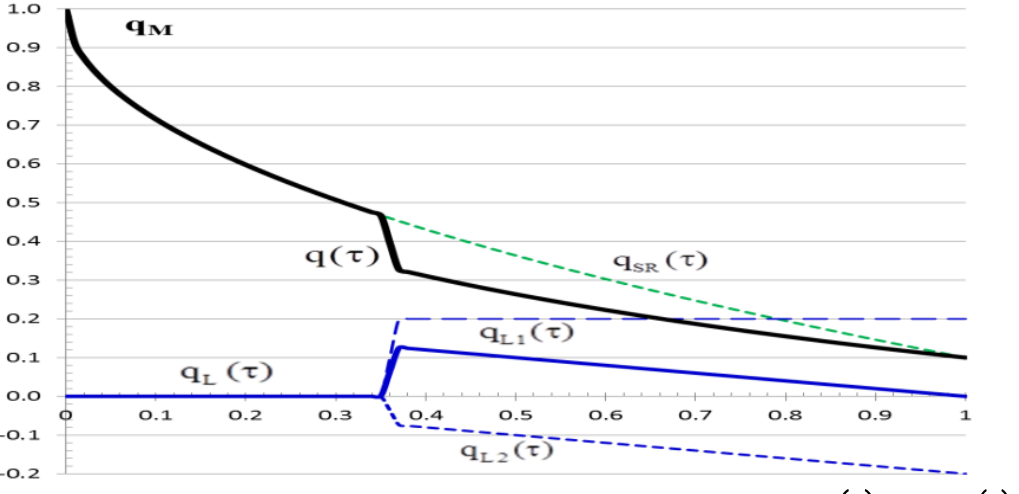
Figure 3. Load duration curve q( τ ) and